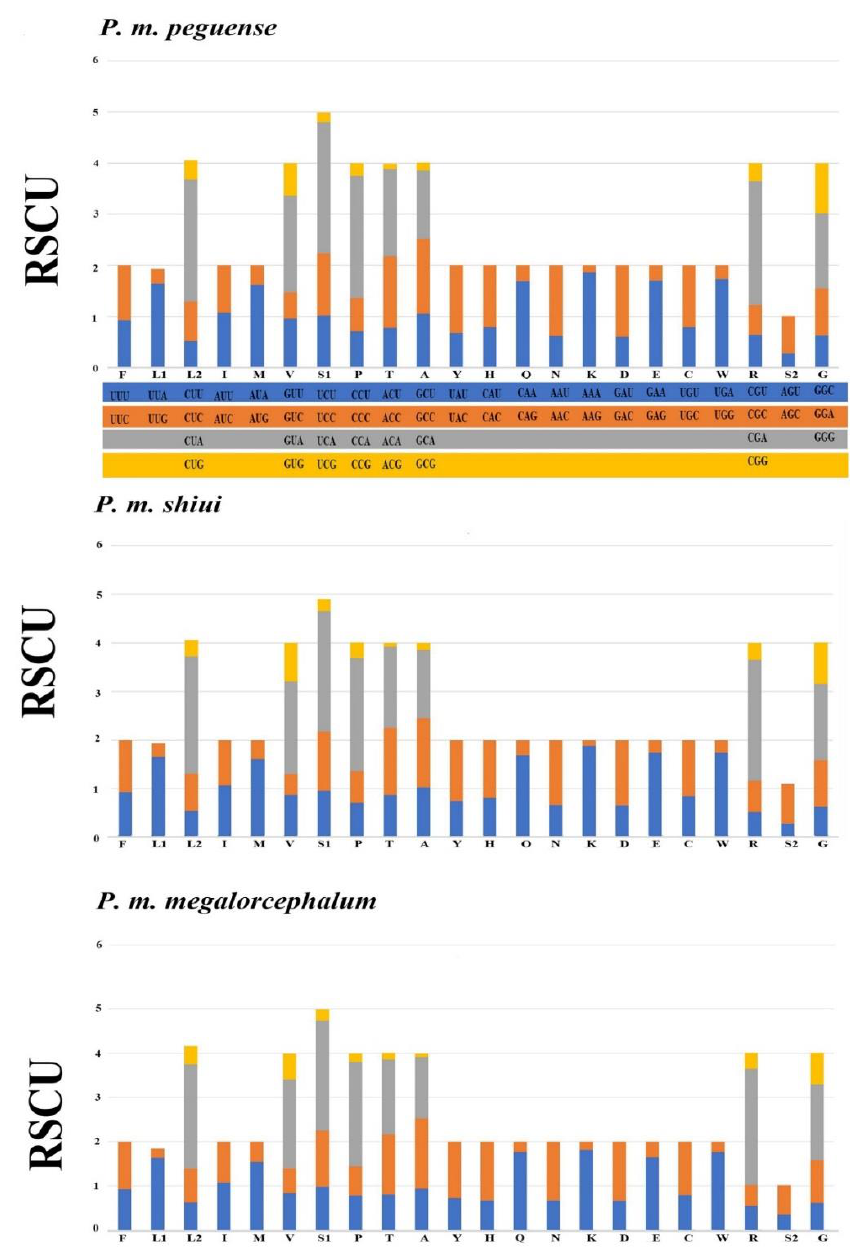
Figure 2. Relative synonymous codon usage (RSCU) in the mitogenomes of three subspecies of Platysternon . The codon-encoded amino acids are labeled according to the IUPAC-IUB single-letter amino acid coding, which excludes both the start codon and the stop codon. The different colors in the column chart represent the codon families corresponding to below amino acids, and the three subspecies use consistent colors to represent the same codon families.